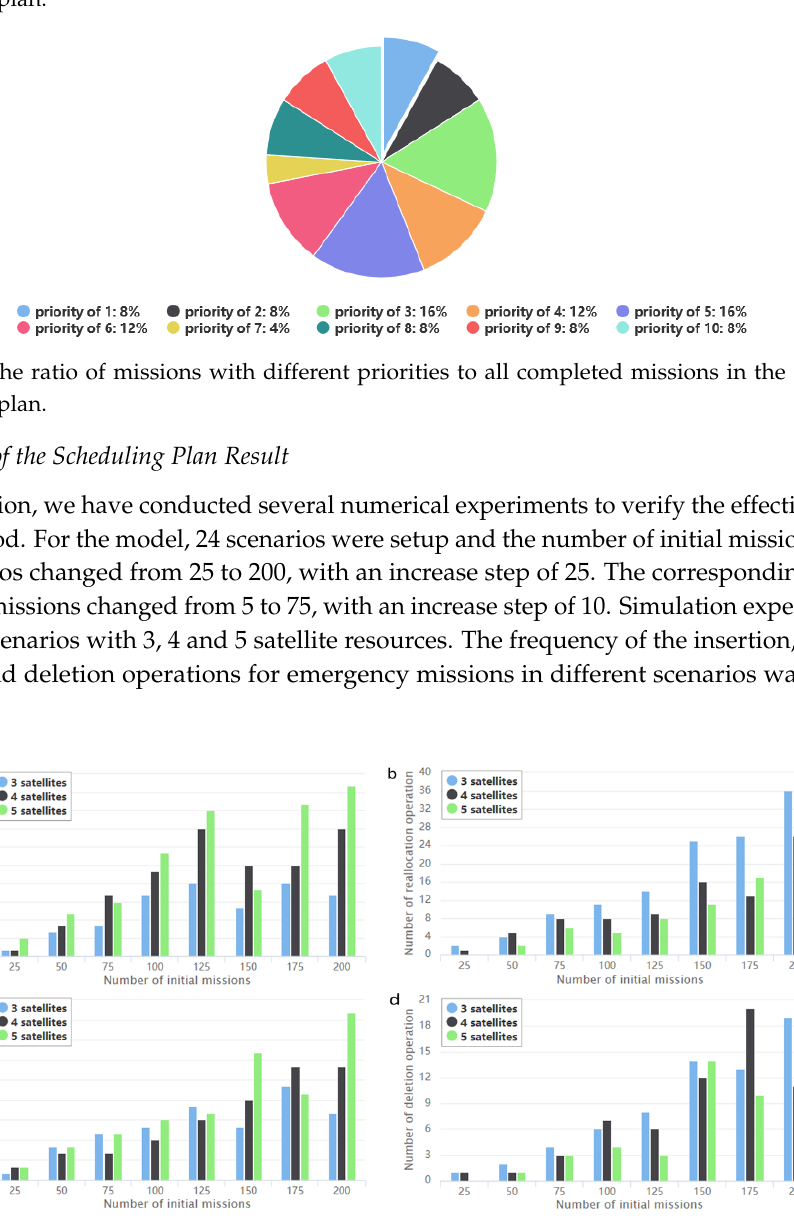
Figure 5. The numbers of the four types of operations performed in dynamic scheduling under different simulation scenarios. ( a – d ) are the scheduling results for insertion, reallocation, replacement and deletion